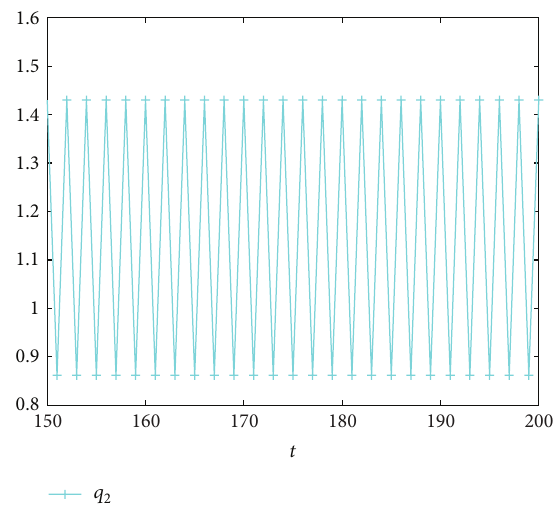
Figure 11: The wave plots of the output 𝑞 2 with the change of time when 𝛼 1 = 1.02 , 𝛼 2 = 1.46 and 𝜃 = 0.436 .